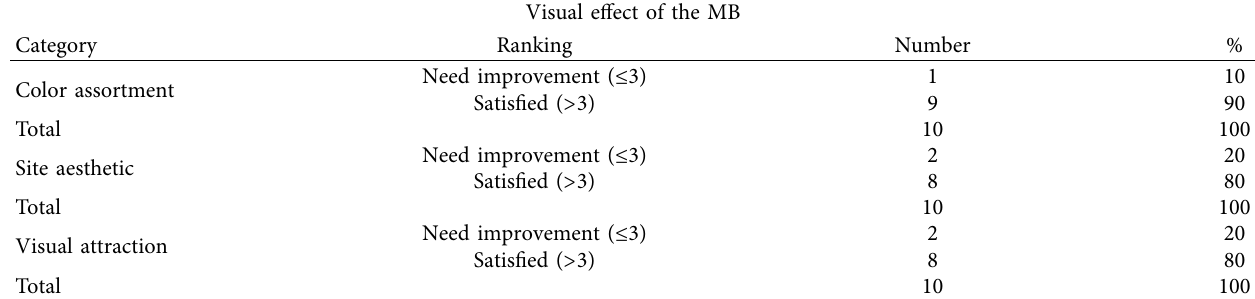
Table 5: Summary of the visual effect of the